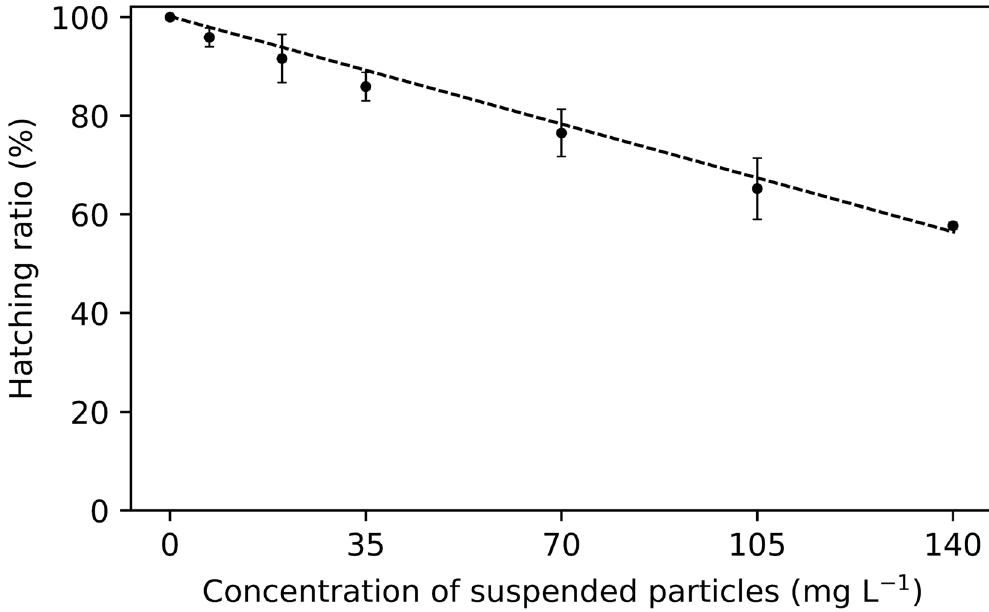
Figure 1. Relationship between suspended particle concentration and relative hatching ratio of pelagic shrimp Lucensosergia lucens eggs ( p <